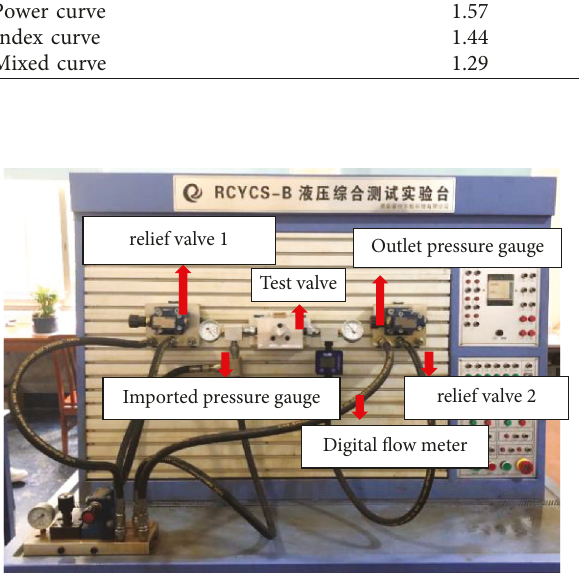
Figure 7: Experimental